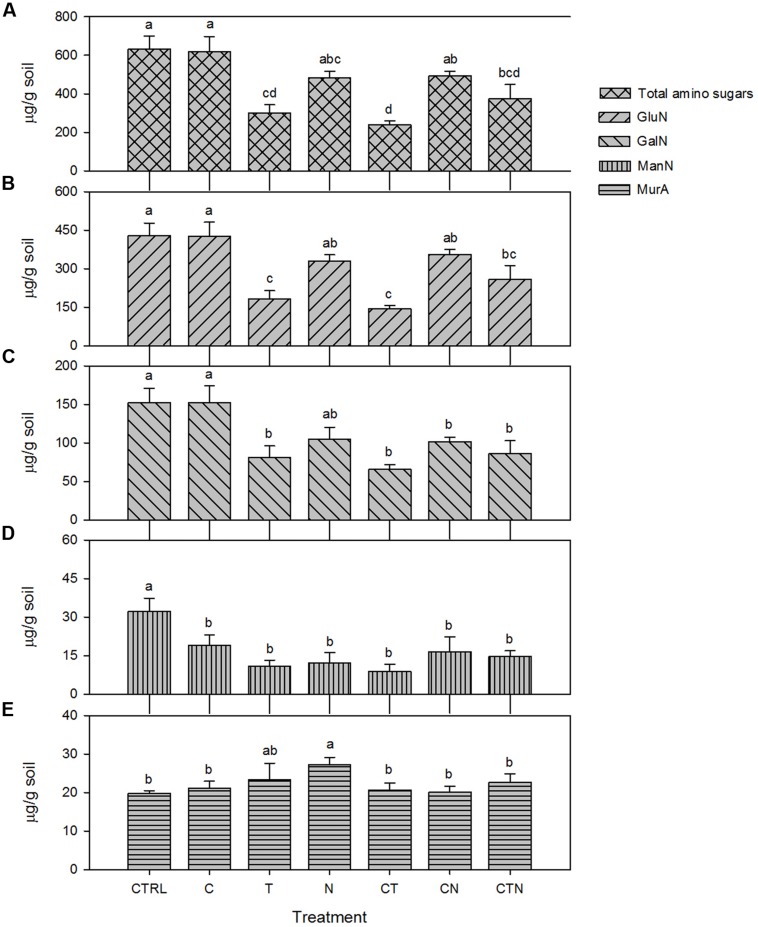
Absolute abundance in bulk and individual amino sugars (μg/g soil) under single and combined global change treatments. Bars indicate SE of the mean (n = 4 or 5). Bars sharing the same letter are not significantly different (P = 0.05, LSD test). CTRL, control; C, elevated CO2; T, elevated temperature; N, nitrogen deposition; GluN, glucosamine; GalN, galactosamine; ManN, mannosamine; MurA, muramic acid.